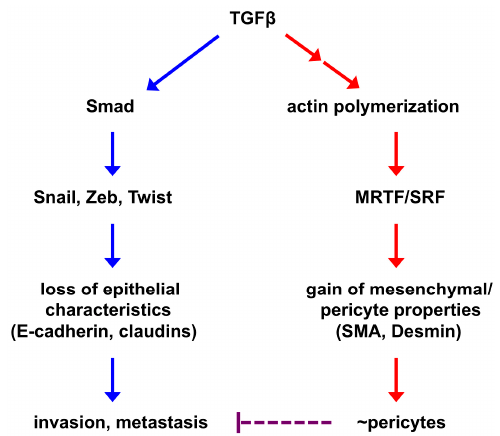
Figure 2. A simplified model of EPT regulation. EMT-inducing signaling causes epithelial cells to lose epithelial characteristics and acquire mesenchymal features. These two processes are largely independent of each other and governed by distinct transcriptional programs. The core EMT-TFs (Snail, Zeb, Twist) repress the epithelial phenotype and may promote tumor invasion and metastasis. Activation of the mesenchymal phenotype is at least in part mediated by the SRF transcription factor and its coactivators MRTFs, which are also central regulators of mural cells. Therefore, mesenchymal cells derived from EMT may inherently resemble pericytes and are able to associate with and stabilize blood vessels (this process is termed EPT). As EMT consists of a broad spectrum of intermediate phases, EPT is one of the EMT outputs. Improved pericyte coverage has been suggested to suppress tumor metastasis; therefore, EPT cancer cell-stabilized vasculature may impede metastatic spread of other cancer cells. Cancers 2017 , 9 , 77